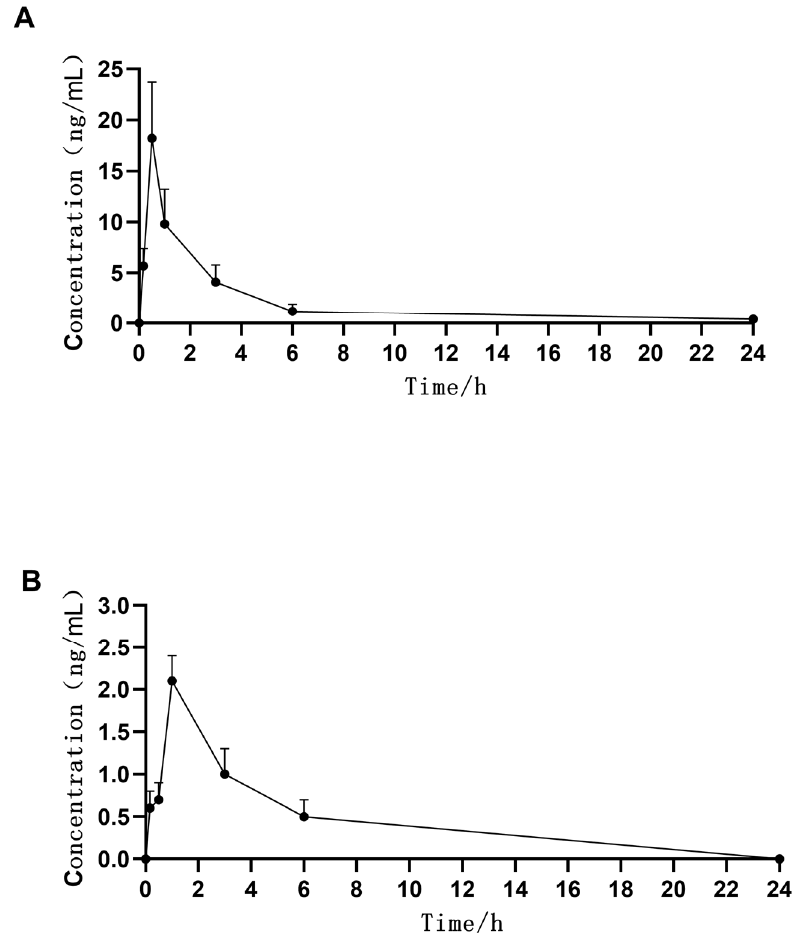
Figure 5. Concentration–time curves of MFH ( A ) and DSP ( B ) in rabbit plasma following single topical ocular administration. Data are shown as the mean + SD (n = 6 for plasma). MFH, moxifloxacin hydrochloride; DSP, dexamethasone sodium phosphate.